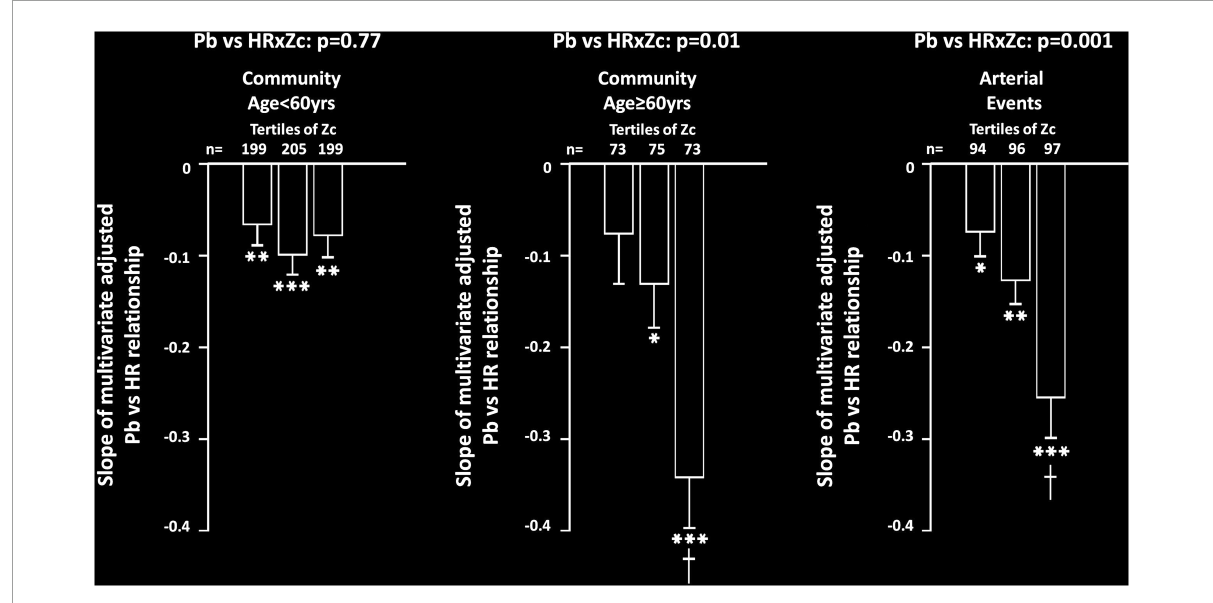
FIGURE2 Impact of proximal aortic characteristic impedance (Zc) on multivariate adjusted slopes ( β -coefficient) of relationships between heart rate (HR) and backward wave pressures (Pb) in participants from a community sample either younger (community < 60 years) or older (community ≥ 60 years) than 60 years or in those with arterial events (stroke or critical limb ischemia). Relationships are shown across tertiles of Zc in each group. All data are adjusted for age, sex, MAP, BMI, regular smoking, regular alcohol, DM, and antihypertensive therapy. ∗ p < 0.02, ∗∗ p < 0.005, ∗∗∗ p < 0.0001 for relationships. † p < 0.01 vs. slopes of relationships in first and second tertiles of